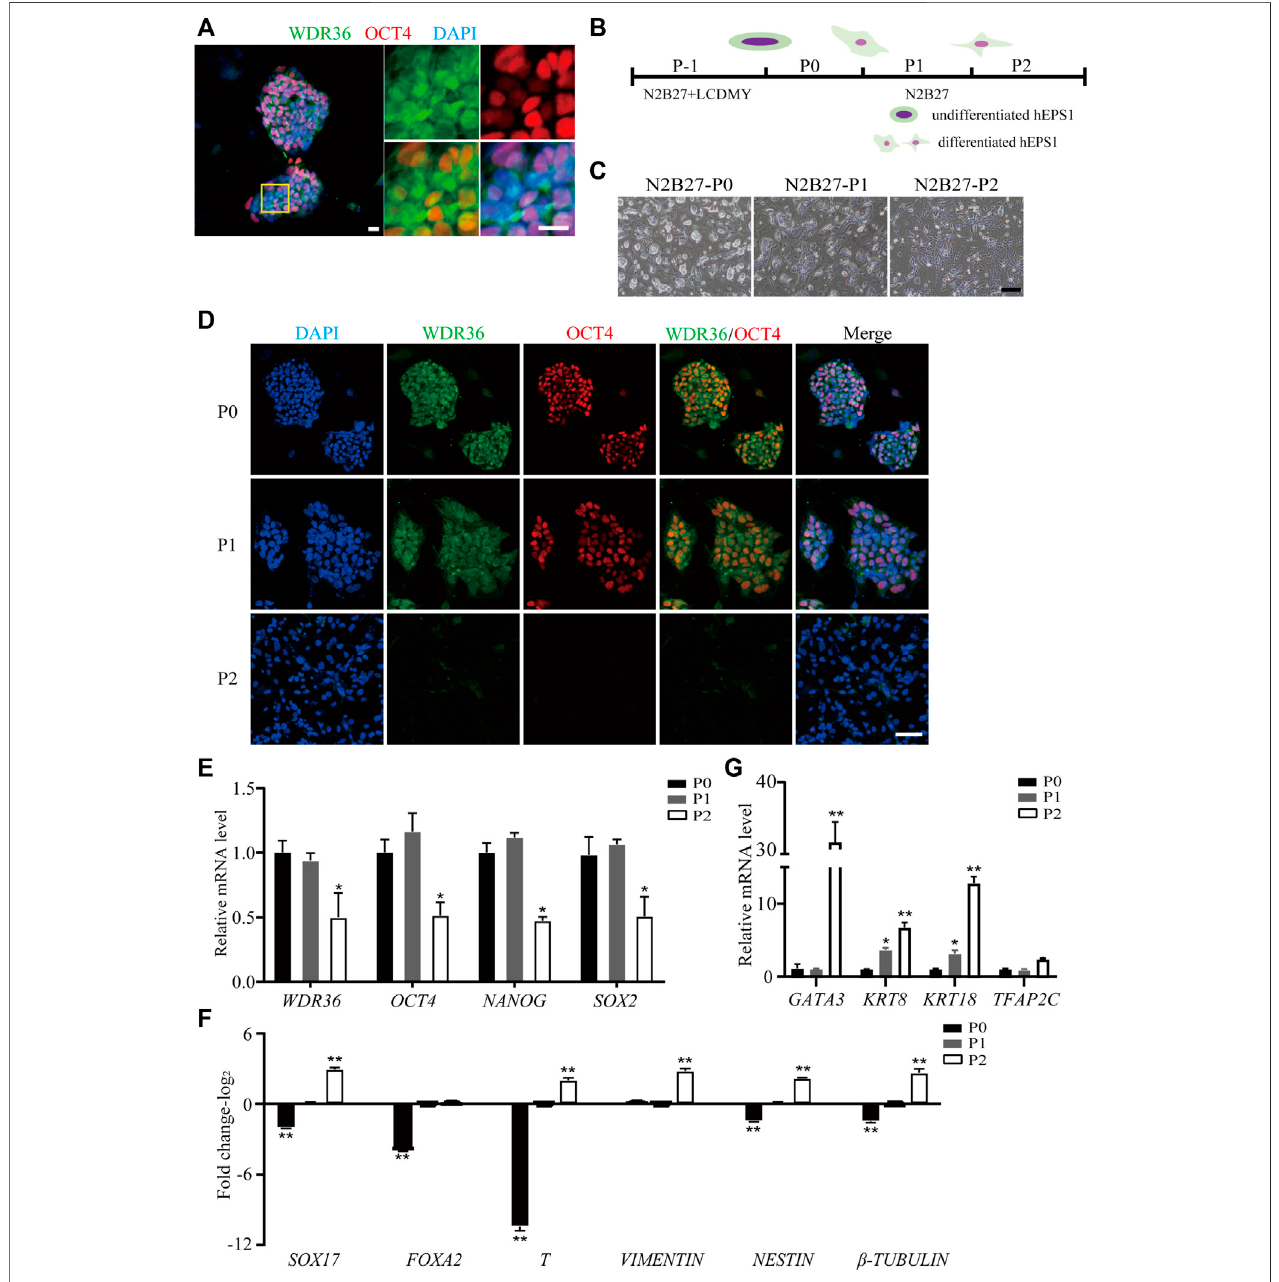
FIGURE1| Down-expressionofWDR36duringhEPS1celldifferentiation. (A) ExpressionofWDR36proteininhEPS1cells.Bars=20 μ m. (B) FlowchartofhEPS1 cellsinaspontaneous differentiation model. (C,D) Representativebright fi eld[ (C) ,Bar=200 μ m]and immuno fl uorescentimages[ (D) ,Bar=50 μ m]ofhEPS1cellsinthe spontaneousdifferentiationassayatP0,P1,andP2,separately. (E – G) Expressionofpluripotentgenes (E) ,embryonicgermlayer-relatedgenes (F), andextraembryonic differentiation-relatedgenes (G) inhEPS1cells cultured inN2B27 medium at P0,P1,and P2. n =3experiments; mean±S.D; two-tailedStudent ’ s t -test.*, 0.01 < p < 0.05; **, p < 0.01; no labeling indicates no statistical signi fi cance.